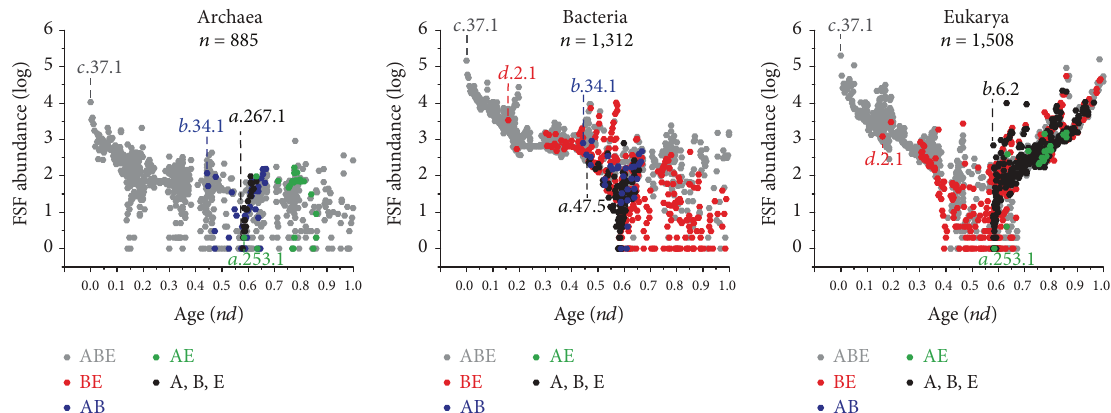
Figure 6: Evolutionary timelines highlighting the abundance of FSFs in superkingdom taxonomic groups. Evolutionary age ( nd ) was calculated from a phylogenetic tree of protein domains describing the evolution of 1,733 FSFs (taxa) in 981 organisms (characters) (see [26, 28, 35] for technical details). SCOP alphanumeric identifiers were used to identify the most ancient FSF in each taxonomic group. In case of multiple FSFs of same age, only the FSF with maximum abundance was labeled. c.37.1 is the P-loop containing NTP hydrolase